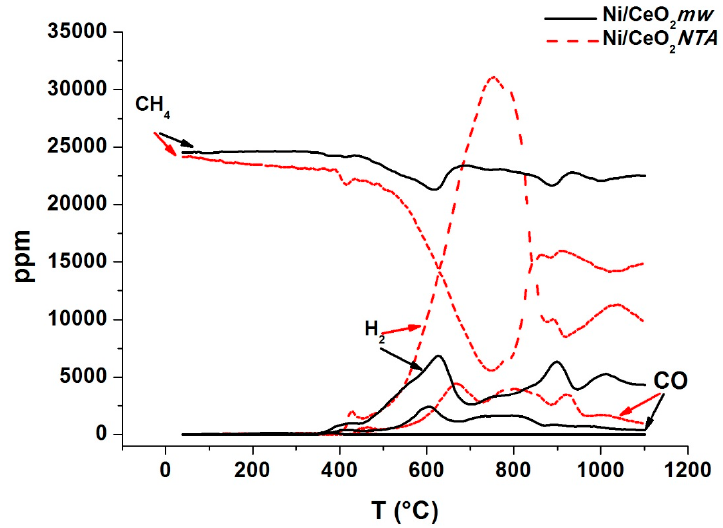
Figure 3. Temperature programmed surface reaction with methane (CH 4 -TPSR) over the two different nickel catalysts pre-reduced in H 2 .